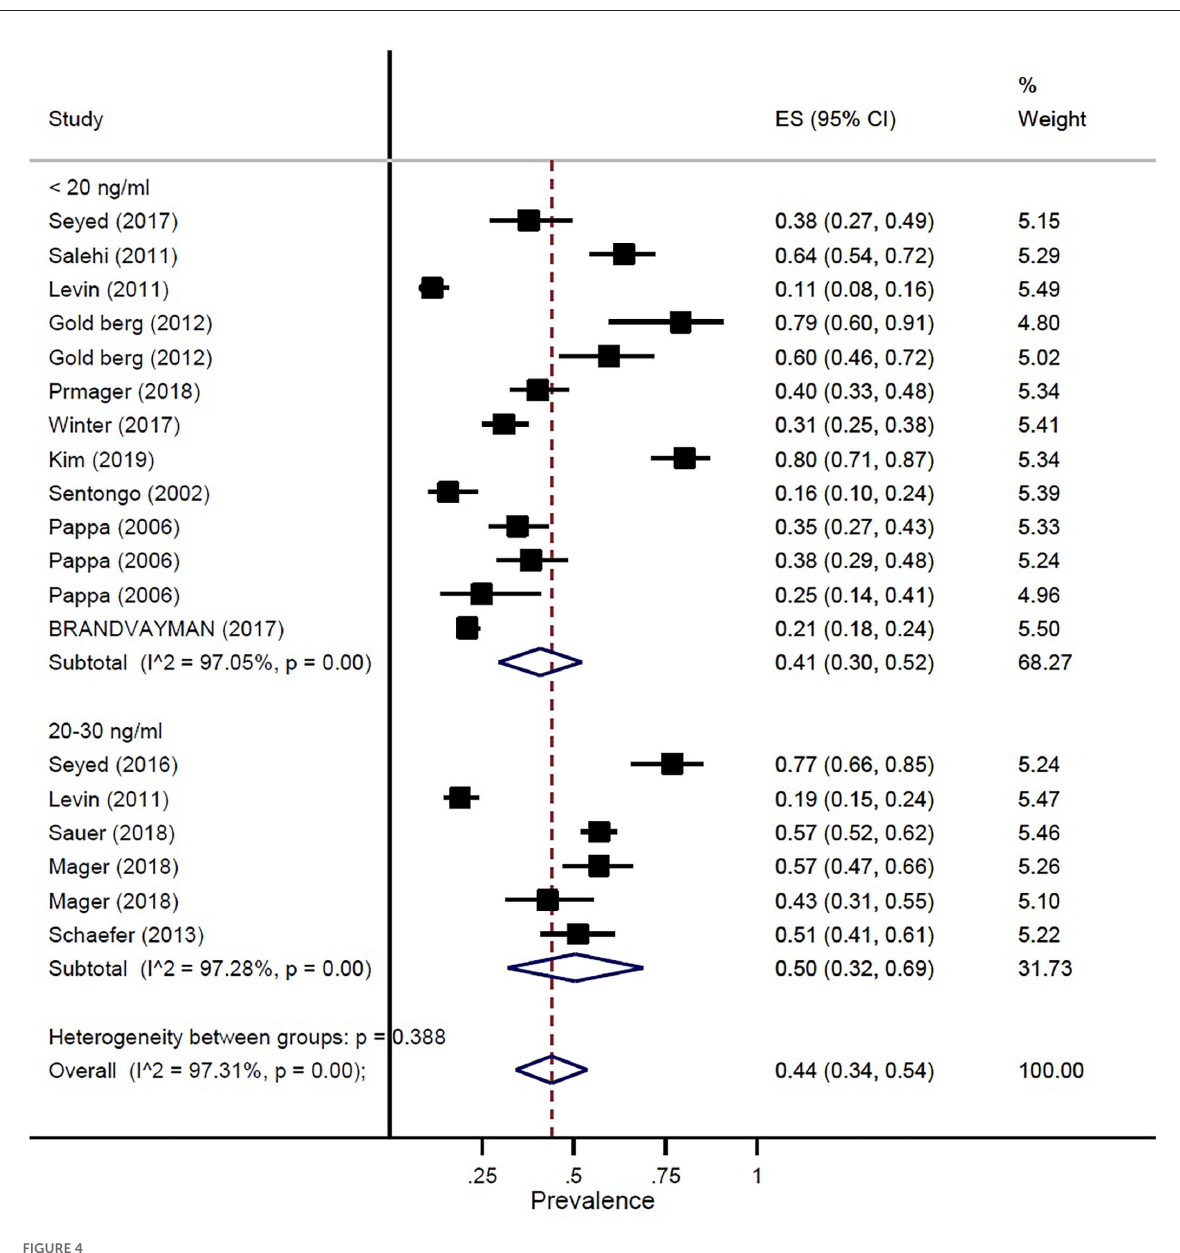
FIGURE4 Pooled estimate of the prevalence of vitamin D status in children and adolescence with